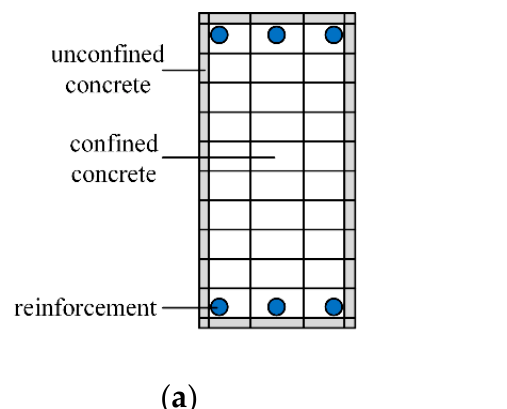
( c ) Figure 3. Material stress-strain relationship curve: ( a ) reinforcement, ( b ) concrete compression, and ( c ) concrete tension.